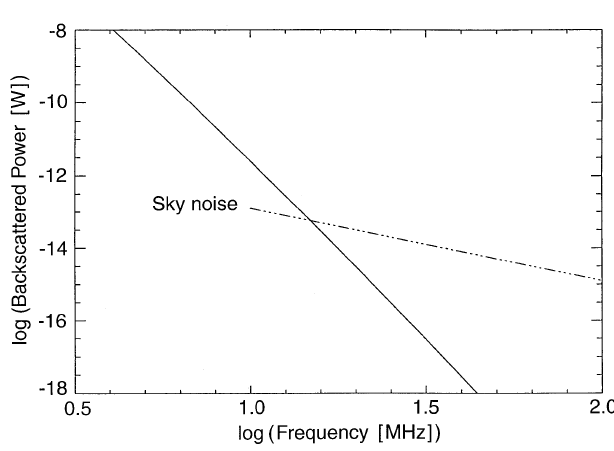
Fig. 6. Received backscatter power with the assumed antenna array and a transmitter power of 50 kW as a function of radar frequency. The dashed - dotted line gives an estimate of the sky